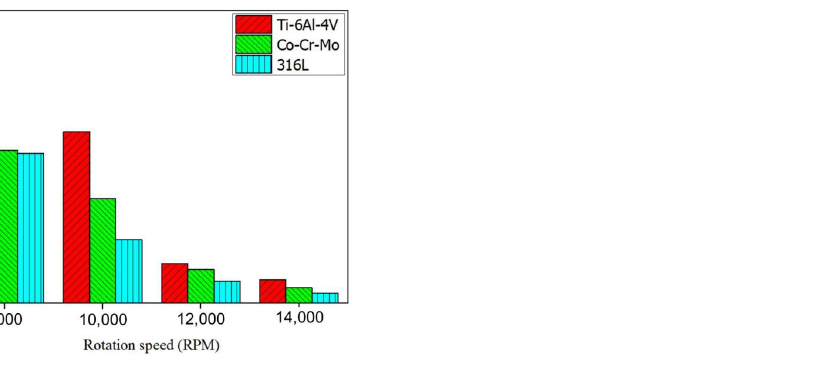
Figure 7. Quantify percentage of powder with pores in the plasma rotating electrode process (PREP) powders as a function of rotation speed.